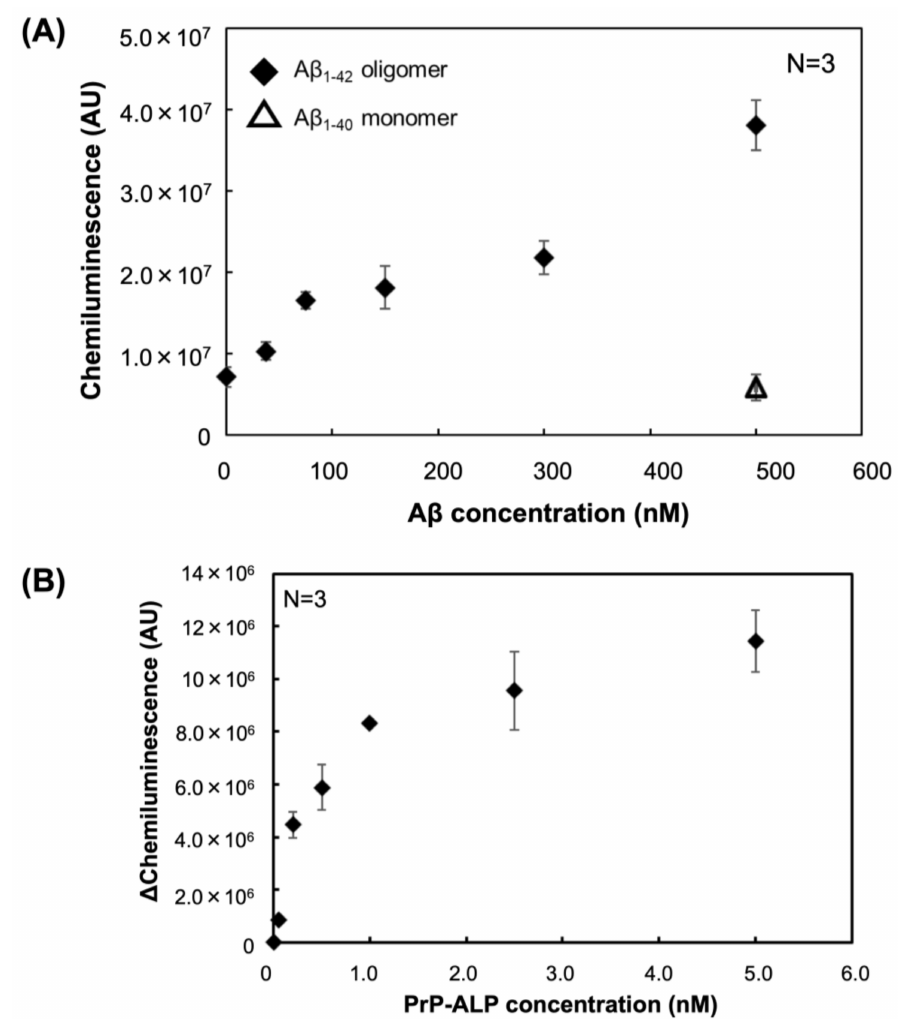
Figure 5. ( A ) Response chemiluminescent signals for A β 1–42 oligomers (closed diamond) and A β 1–40 monomer using a sandwich assay that consists of anti-A β antibody and PrP-ALP. ( B ) Evaluation of the dissociation constant of PrP-ALP toward A β oligomers with the sandwich assay. The data are shown as the mean ± SD in the graph ( n =